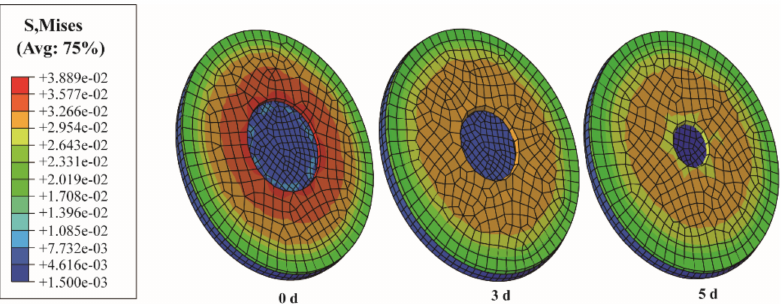
Figure 7. The finite element model showing distribution of local Mises stress in wound and surround- ing tissue.